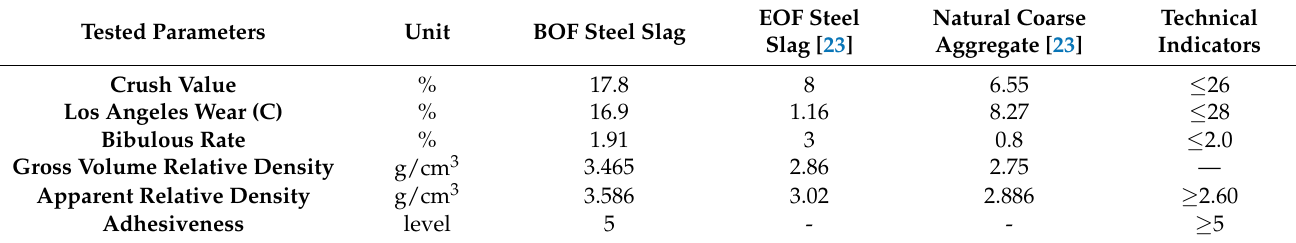
Table 2. Physical properties of steel slag.